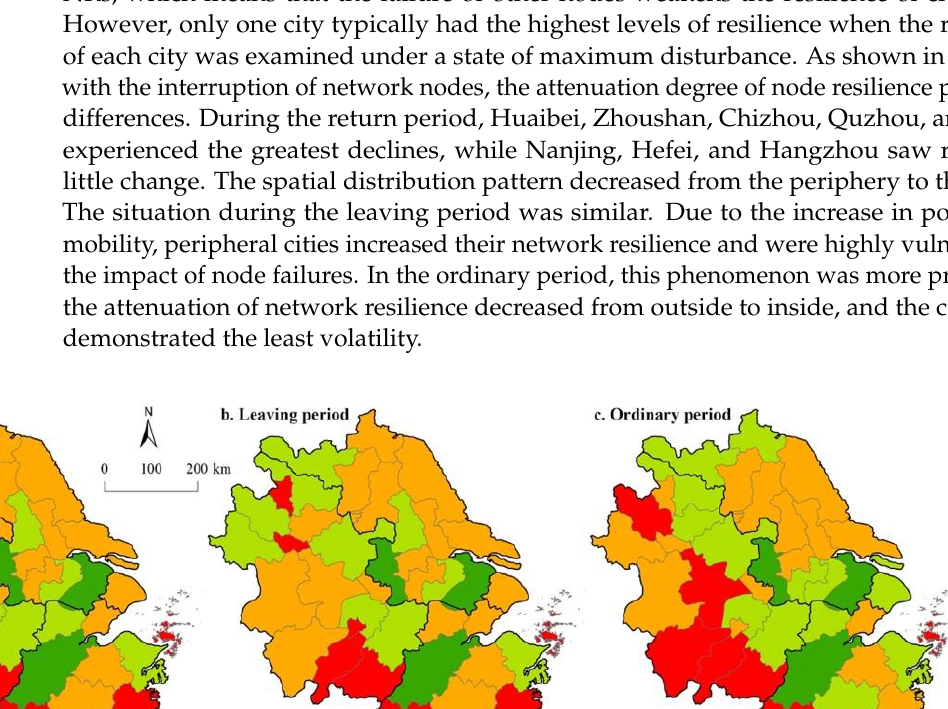
15 of 21 Figure 7. Spatial pattern of the impact of urban node failure on network resilience.